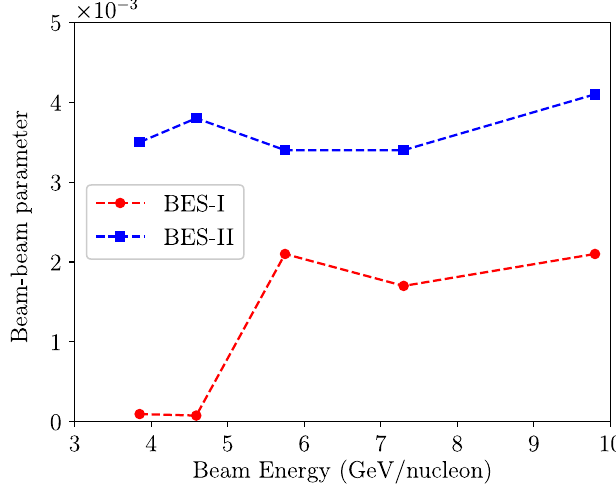
FIG. 11. Beam-beam parameters in BES-I and BES-II at various beam energies.